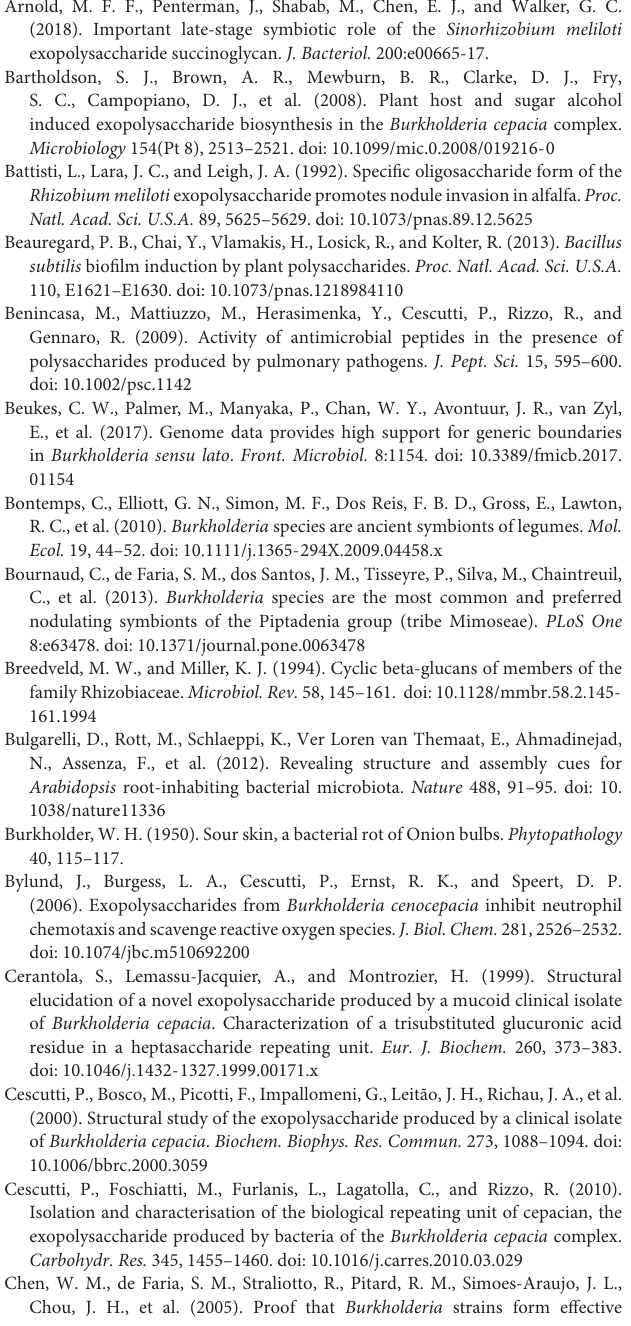
show statistically significant induction of GFP expression in this group. Error bars indicate the standard error of the mean (SEM). ∗∗∗∗ p < 0.0001, ∗∗∗ p < 0.001, and ∗∗ p < 0.01. FIGURE S4 | Organization of bce -I and bce -II clusters in selected Paraburkholderia and Burkholderia sensu stricto strains (figure modified from Eberl and Vandamme, 2016, phylogenetic tree based on 16S rRNA). TABLE S1 | Bacterial strains, plasmids, and oligonucleotides used in this